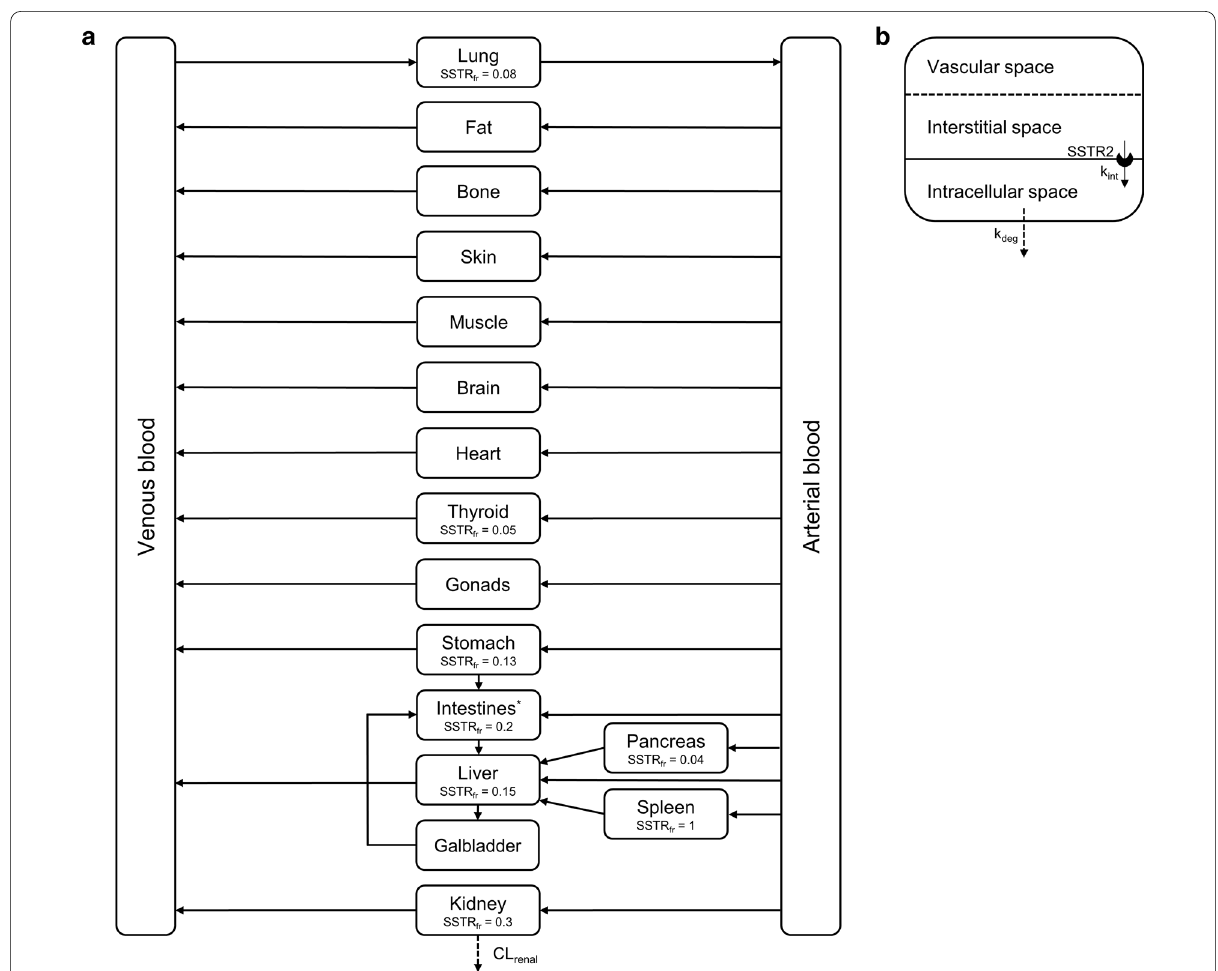
Fig. 1 Schematic overview of the developed 68 Ga‑DOTATATE PBPK model ( a ), with all organ compartments included and arrows representing blood flow. Each organ compartment consists of subcompartments ( b ), where peptide transfer from interstitial to intracellular space occurs by internalization of the SSTR2 receptor after peptide binding. *Intestinal compartment consists of small intestine (SSTR2 fraction intestine (SSTR2 fraction 0.11). CL renal : renal clearance; k int : internalization rate; k deg : degradation rate; SSTR fr :somatostatin receptor =